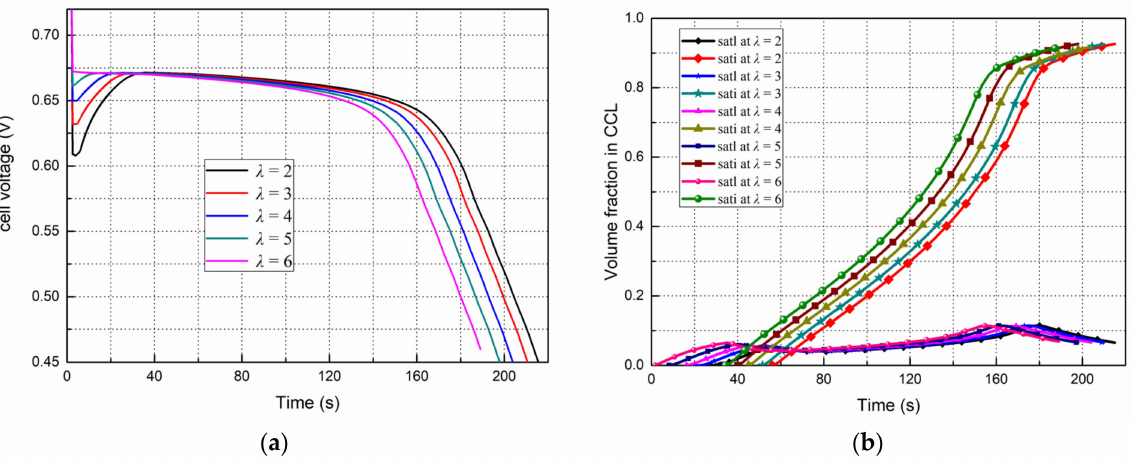
Figure 10. Effects of the initial membrane water content on the start processes from − 20 ◦ C, 0.08 A/cm 2 . ( a ) Performance evolution ( b ) Liquid and ice saturation in the cathode